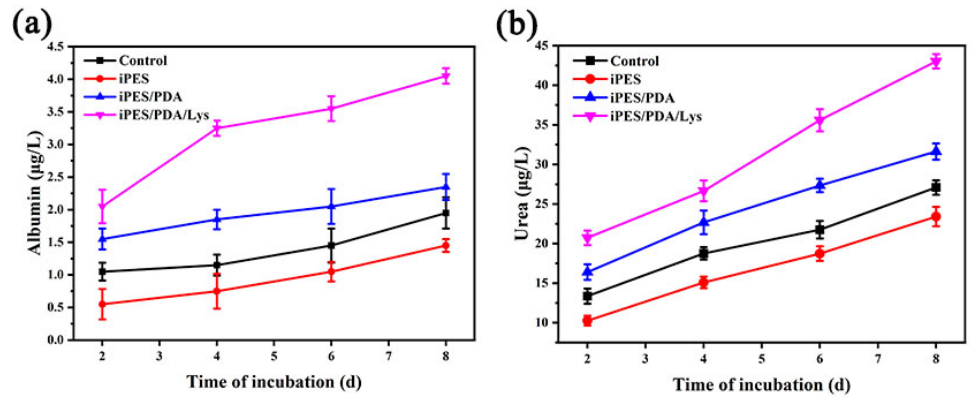
Figure 9. Albumin secretion ( a ) and urea formation ( b ) of C3A cells inoculated on the membranes. Control groups were treated without membranes. The values are expressed as means ± SD (n = 3). Table 3. Bilirubin removal rate of the membranes from plasma of patients with jaundice.